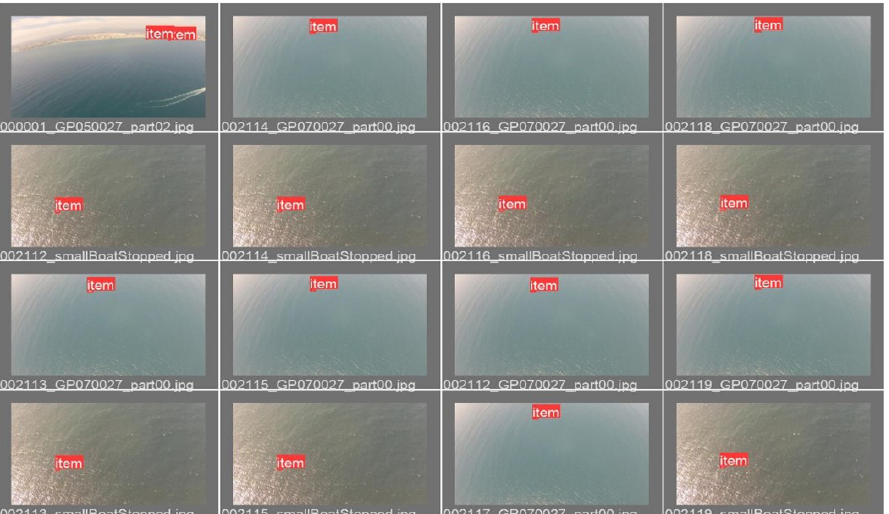
Figure 11. Examples of annotated images from the SEAGULL test set—ground truth bounding boxes visible.